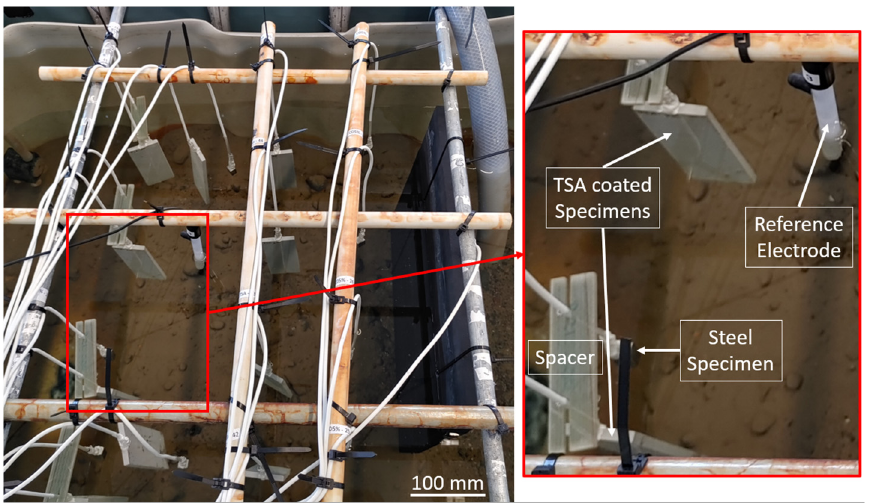
Figure 4. The test setup in IBC with the graphite counter electrode to the right, the reference electrode in the middle, and the specimens arranged around it. The galvanic couples are on the left side. The thermal spray-coated specimens are in the middle of the picture and the bare steel specimens are placed to their right.